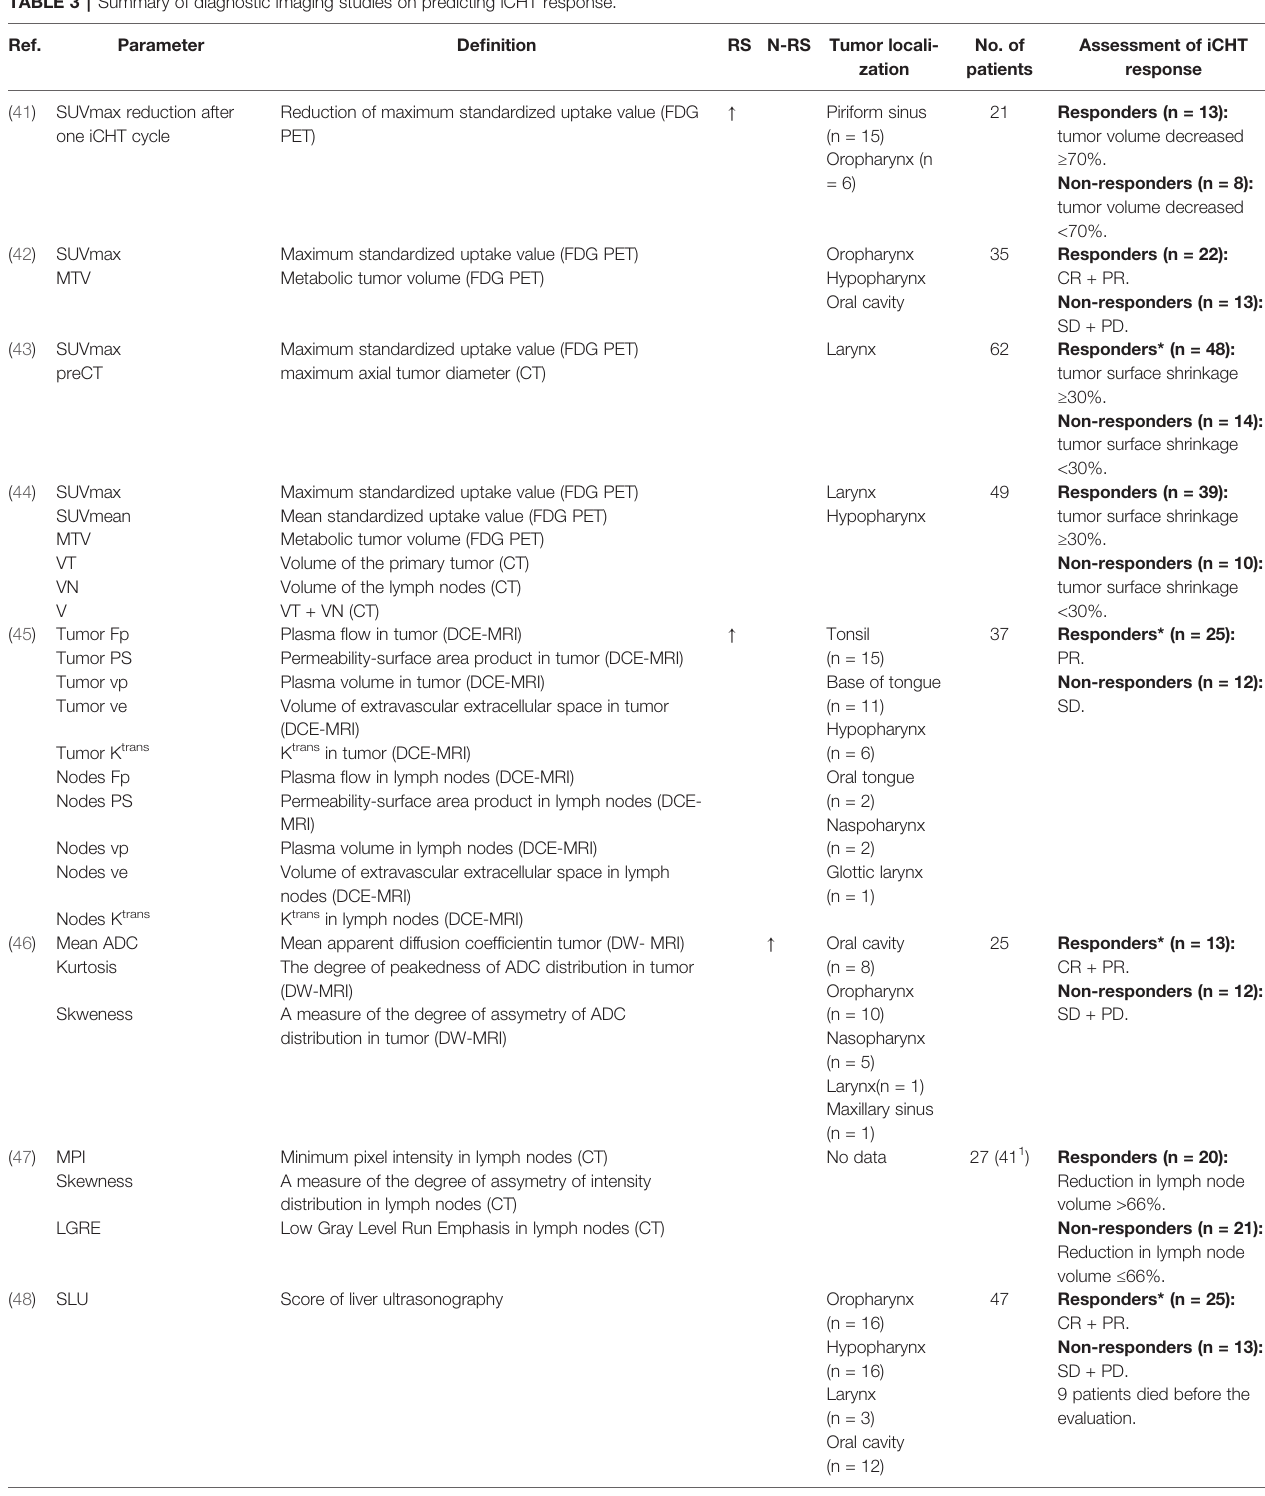
TABLE 3 | Summary of diagnostic imaging studies on predicting iCHT response.